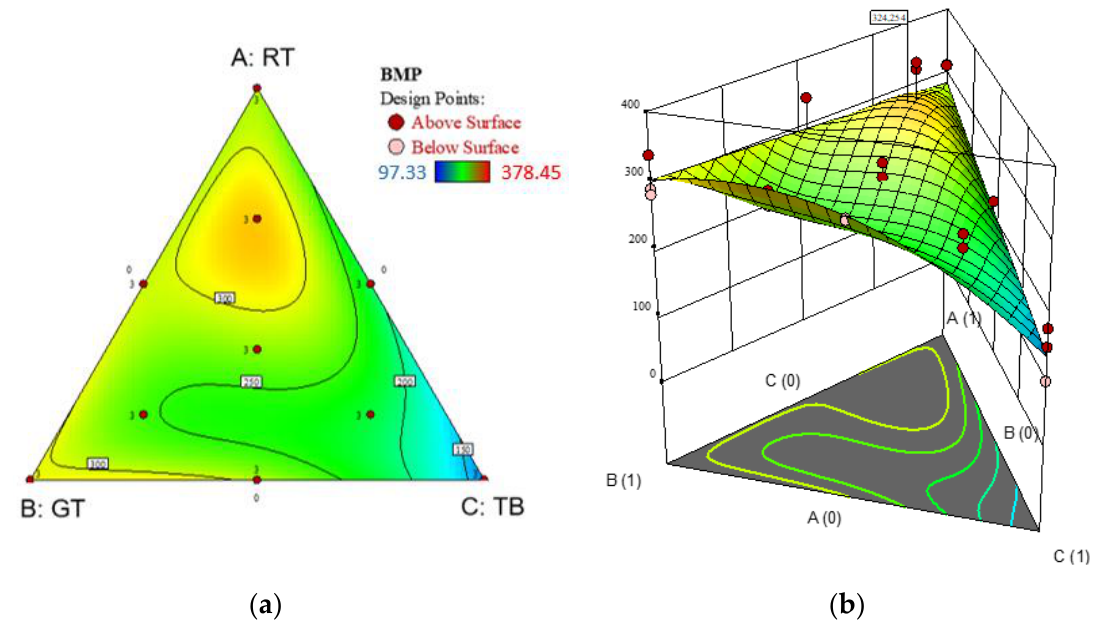
Figure 5. Contour ( a ) and surface ( b ) plot of the BMP response described by the special quartic model.